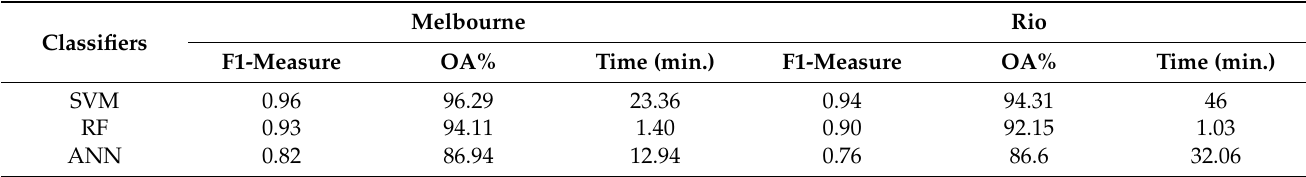
Table 3. F1-measure value and process time for classification of PSO_NCA feature dataset in Mel- bourne and Rio.